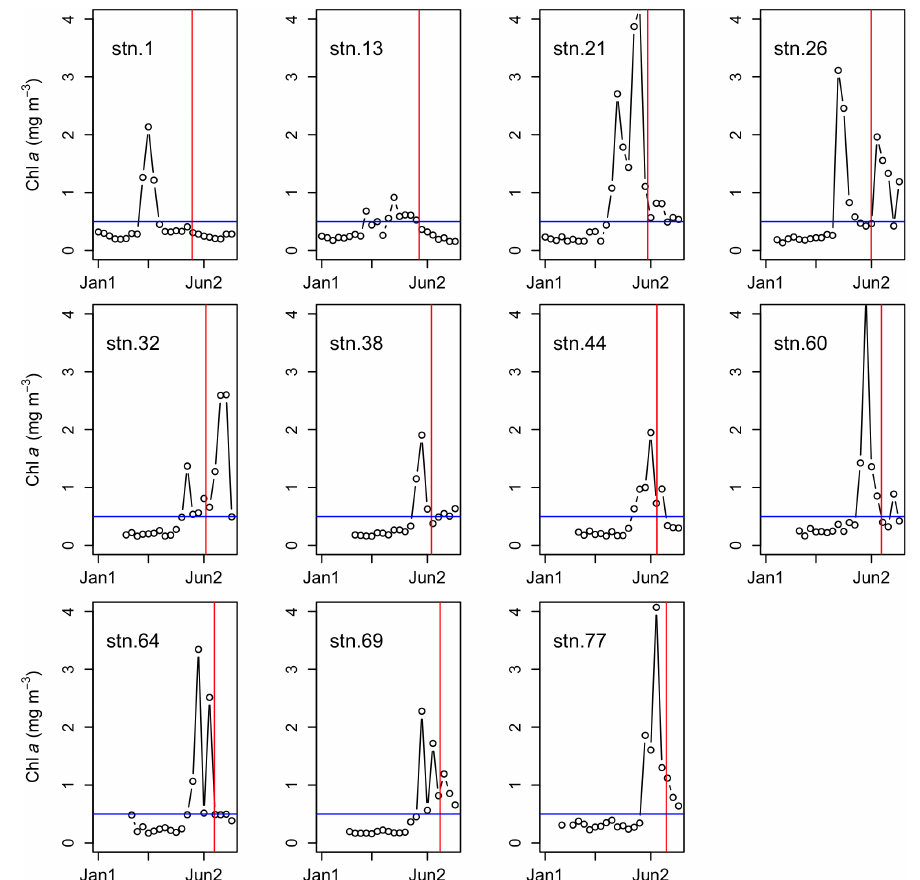
Figure 6. Time-series (1 January–12 July 2014) chlorophyll- a concentrations (8-day averages) from Aqua MODIS (https://oceancolor. gsfc.nasa.gov; last access: 6 September 2018) at each station along the GA01 transect. The vertical red line denotes the sampling date at each station. The horizontal blue line denotes chlorophyll- a concentration of 0.5mgm − 3 . The time when chlorophyll- a concentration first exceeded 0.5mgm − 3 after the end of the last bloom defines the date when the next bloom began.